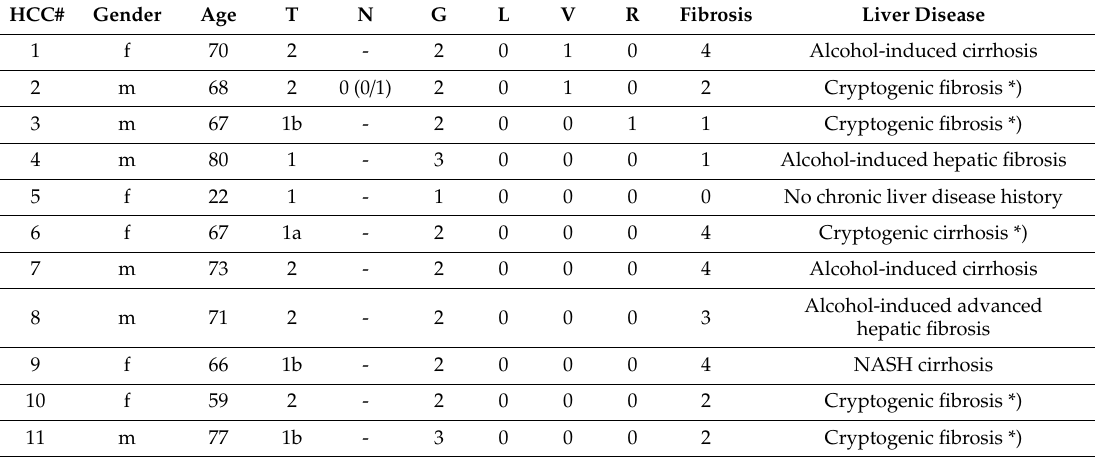
Table 1. Characteristics of tumors and adjacent noncancerous tissues. HCCs were classified according to the Tumor-Nodes-Metastasis classification system of malignant tumors [18]. T(0–4)—tumor size; N(0–3)—spread to regional lymph nodes; G(1–4)—di ff erentiation grade; L(0–1)—invasion into lymphatic vessels; V(0–2)—invasion into vein; R(0–2)—completeness of the operation